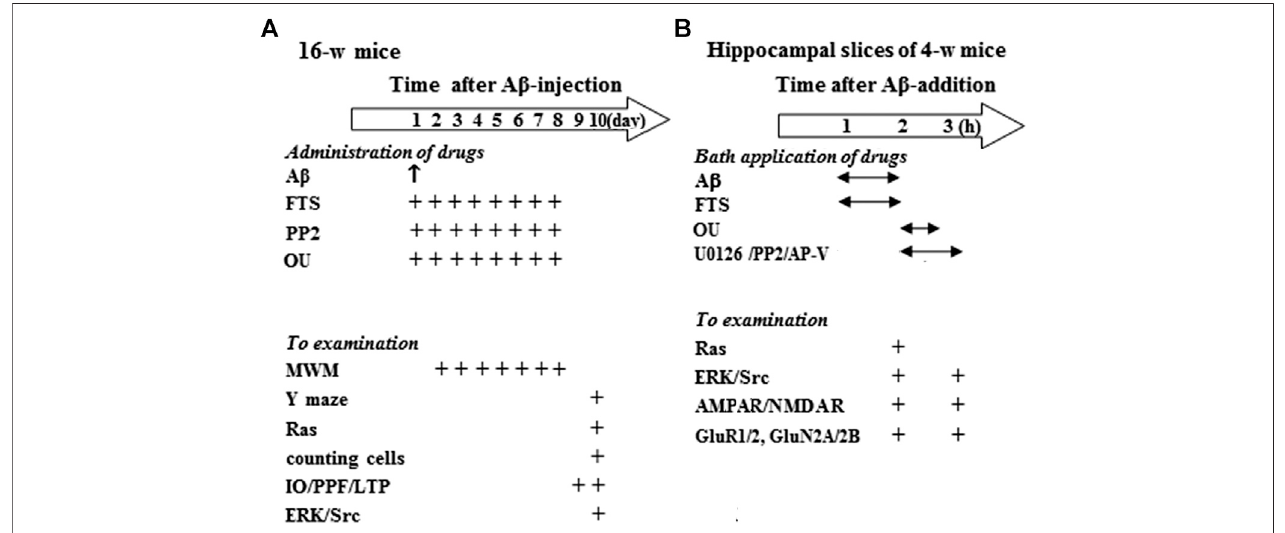
FIGURE 1 | Experimental procedure and group size. (A) Hollow arrow shows time (day) after injection (i.c.v.) of A β 1-42 . “ ↑ ” and “ + ” indicates the times of drugs administration andexamination.MWM:Morriswatermaze. (B) Hollow arrow showstime (h)after A β 1-42 incubation. “ ↔ ” and “ + ” represent thetimes ofA β 1-42 and drugs application, and